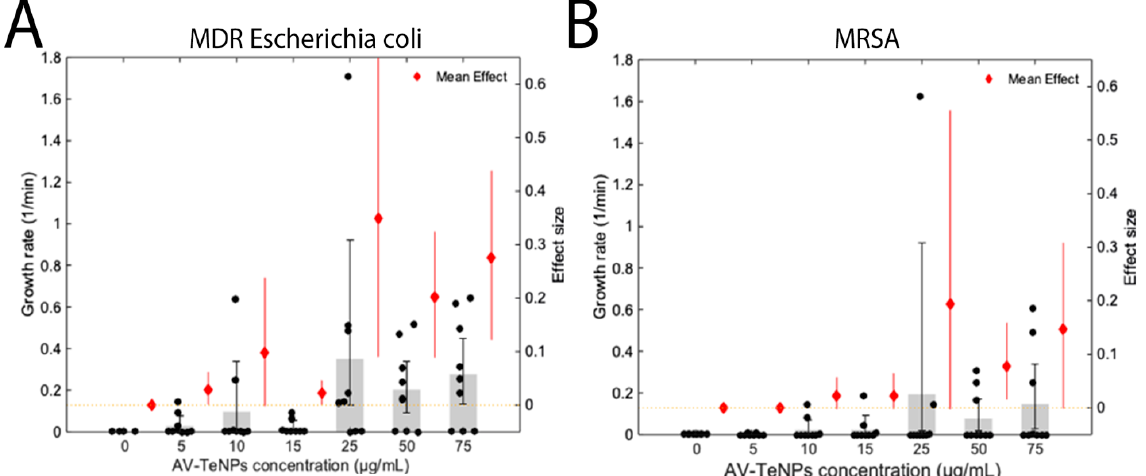
Figure A10. The growth rate and effect size against the shared control 0 concentration are shown in the above Cumming estimation plots for MDR Escherichia coli ( A ) and MRSA ( B ) experiments. Each mean difference is depicted as a diamond with 95% confidence interval indicated by the ends of the vertical error bars. Three measurements were taken for each biological replicate (denoted as a black bold dot, ● ).